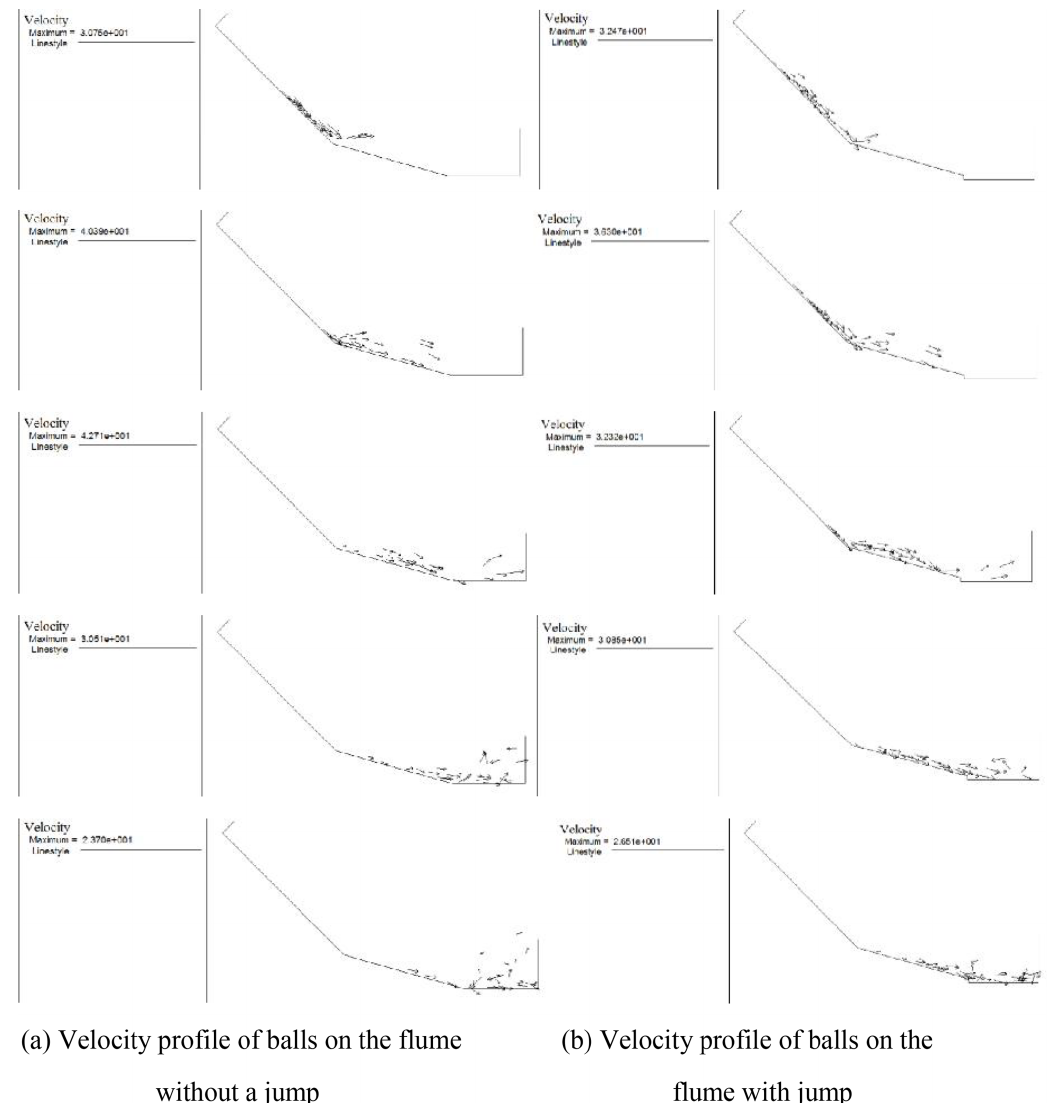
Figure 13. Velocity profile of blue glass balls in the numerical